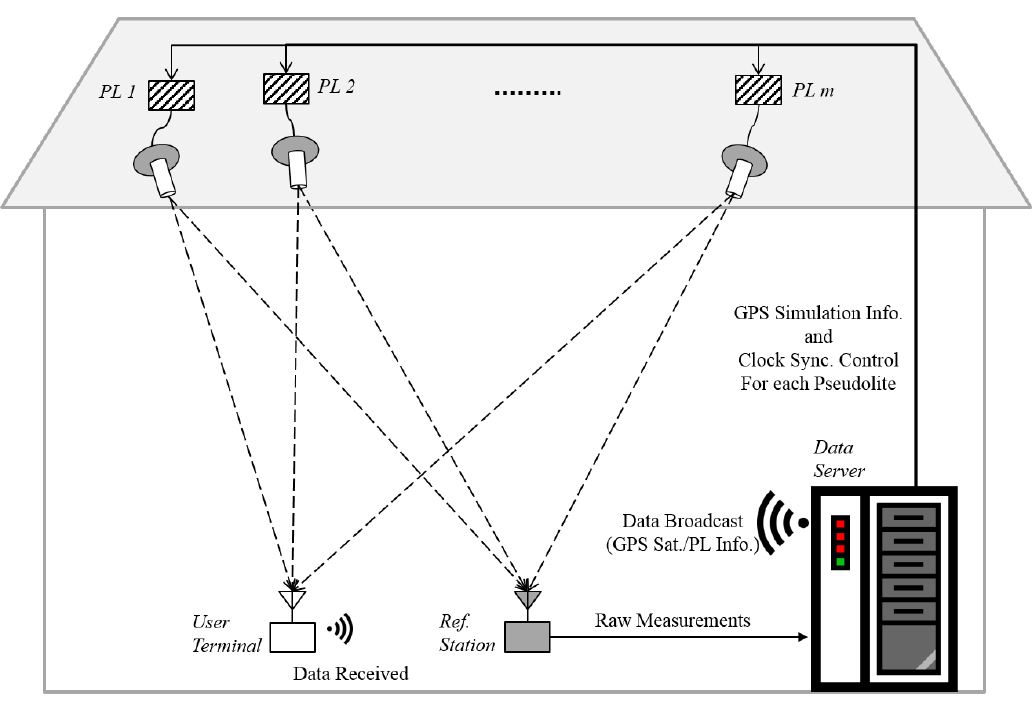
Figure 1. Illustration of proposed system.